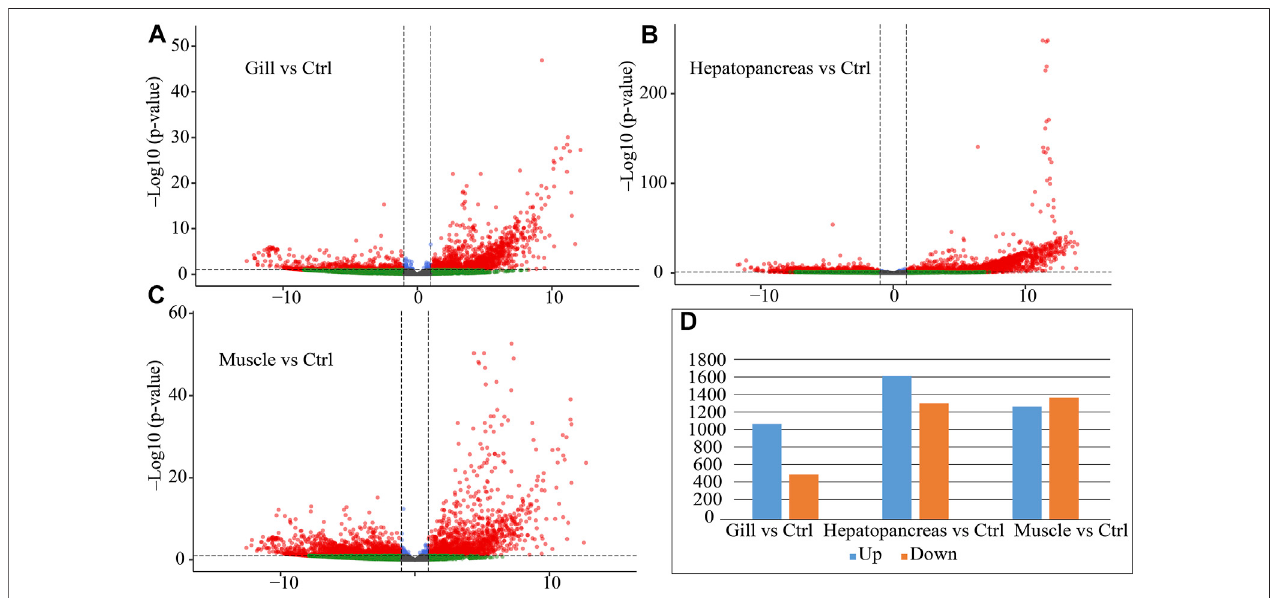
FIGURE 3 | Differential expression statistics for muscle, hepatopancreas and gill tissue. (A) Volcano plot of differential expression between gill and control (hepatopancreas and muscle). (B) Volcano plot of differential expression between hepatopancreas and control (gill and muscle). (C) Volcano plot of differential expressionbetweenmuscleandcontrol(gillandhepatopancreas). (D) Differentialexpressionstatisticsforeachtissue.Note:Ctrl:control;Up:upregulatedgenes;Down: downregulated genes.